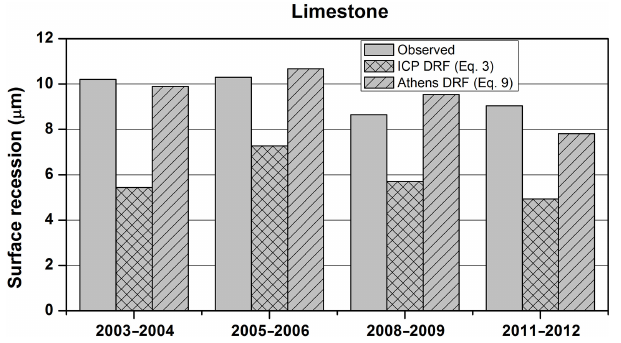
Figure 10. Experimental obtained surface recession values at Athens, Greece for the case of limestone along with the predicted values by DRFs.